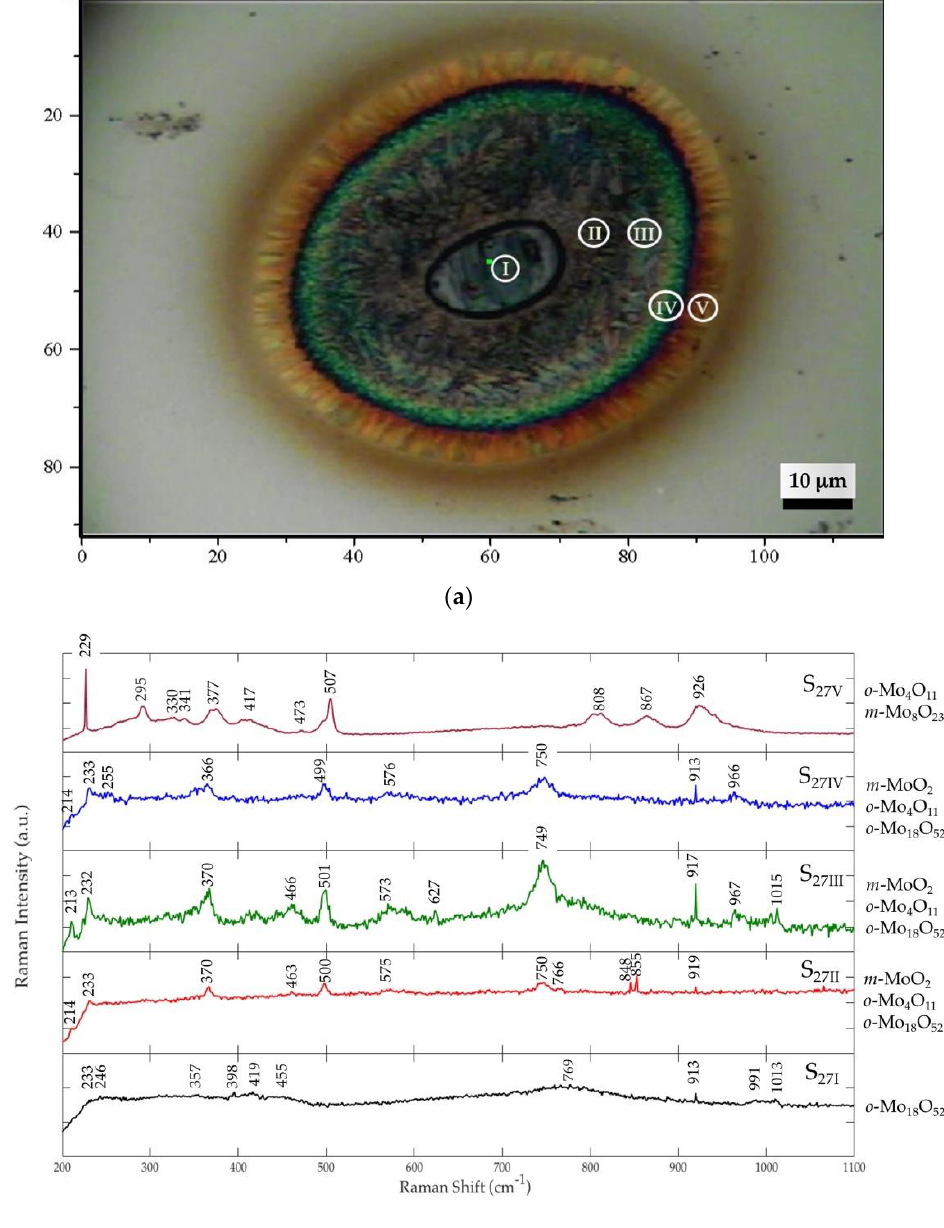
Figure 6. Optical micrograph ( a ) with I–V the positions where Raman measurements were taken, and spatially resolved Raman spectra ( b ) for the irradiated spot S 27 at per-pulse laser fluence 1.9 mJ / cm 2 and 6 min exposure time.